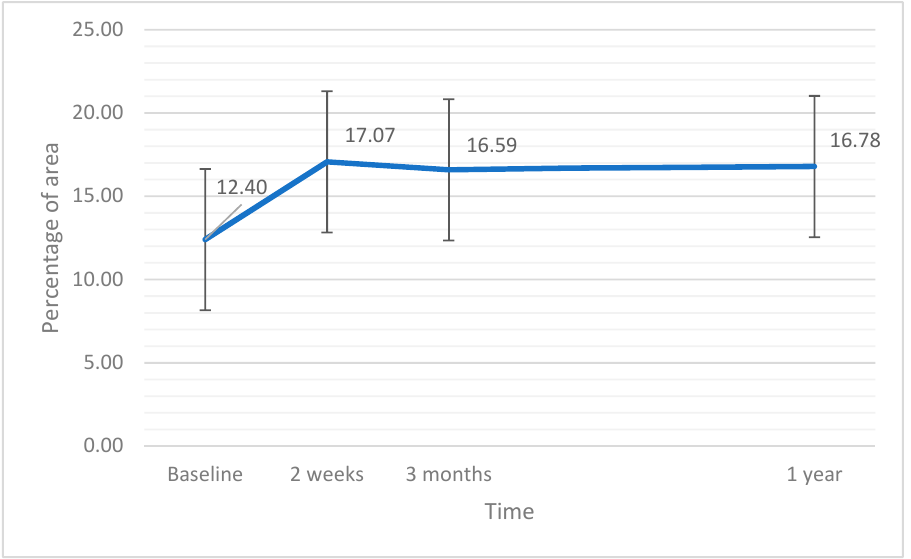
Figure 7. Perfusion at the central part of the retina (PVC) at baseline and after the surgery. The error bars represent 95% CI of the obtained results.